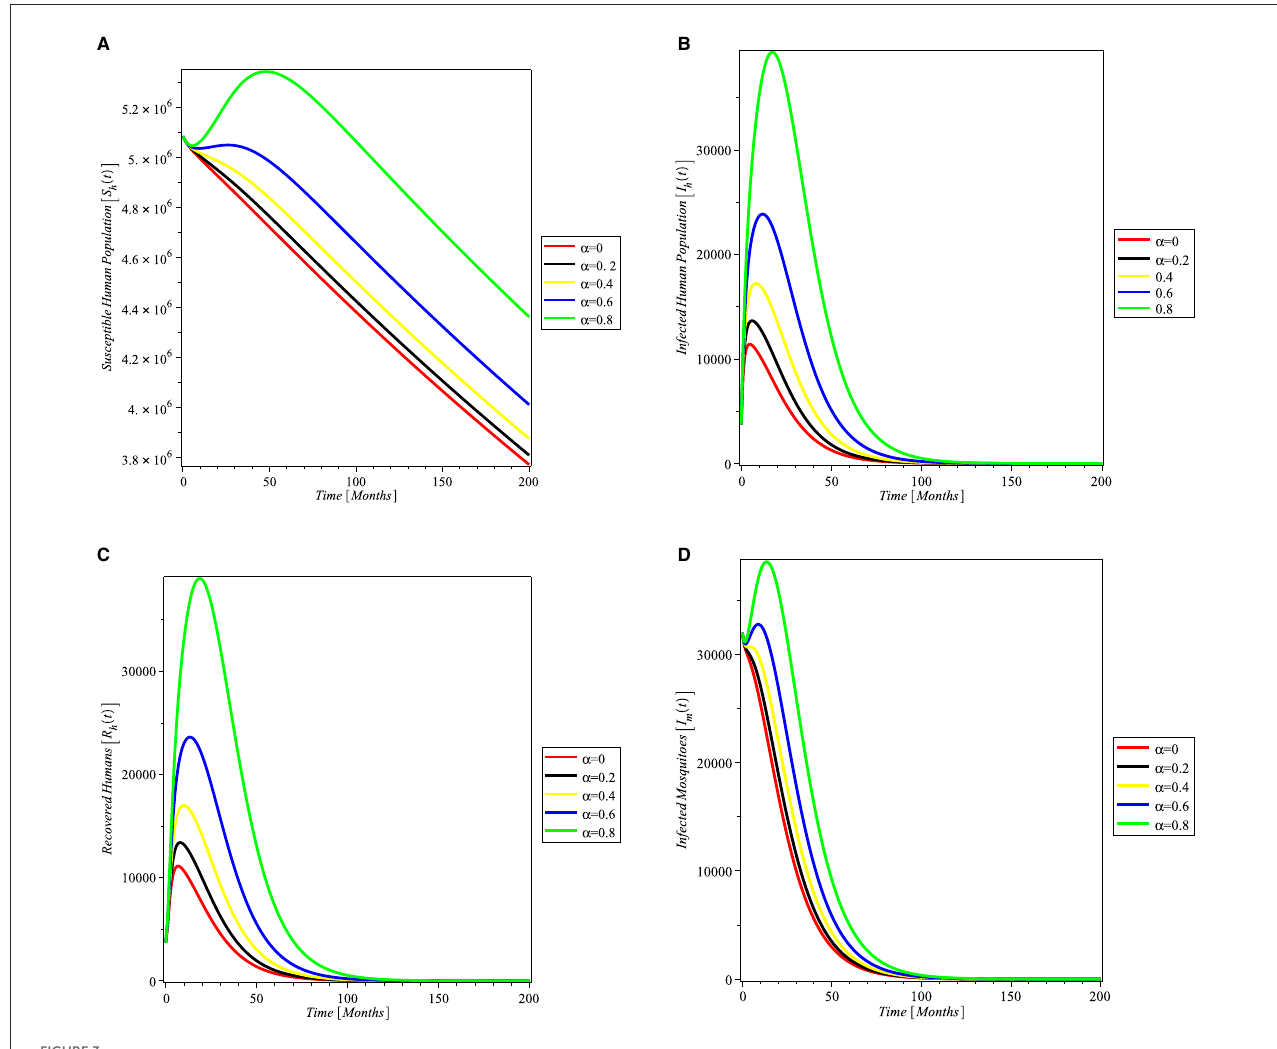
FIGURE3 Simulation showing the impact of transfusion term alpha on (A) susceptible humans, (B) infected humans, (C) recovered humans, and (D) infected mosquitoes, with parameters set given in Table 1.